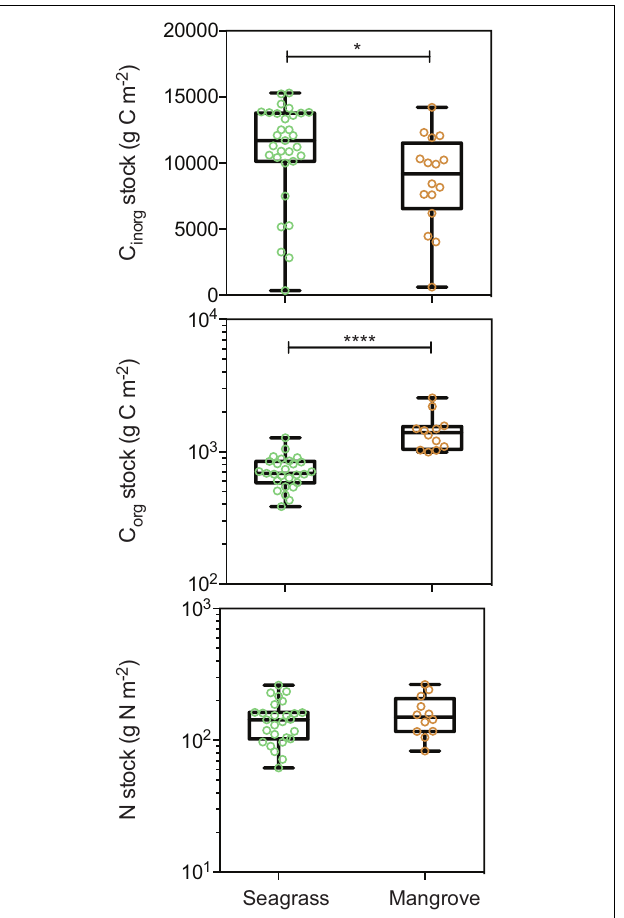
FIGURE 5 | Box plots of C inorg , C org , and N stocks for seagrass (green) and mangrove (brown) sediments showing all data points. Stocks integrated over the top 10 cm of sediment. Boxes extend from the 25 th to 75 th percentiles, lines inside boxes represent median values, and whiskers span from minimum to maximum values. Statistically significant differences are indicated by asterisks where ∗ indicates p < 0.05, and ∗∗∗∗ indicates p < 0.0001.